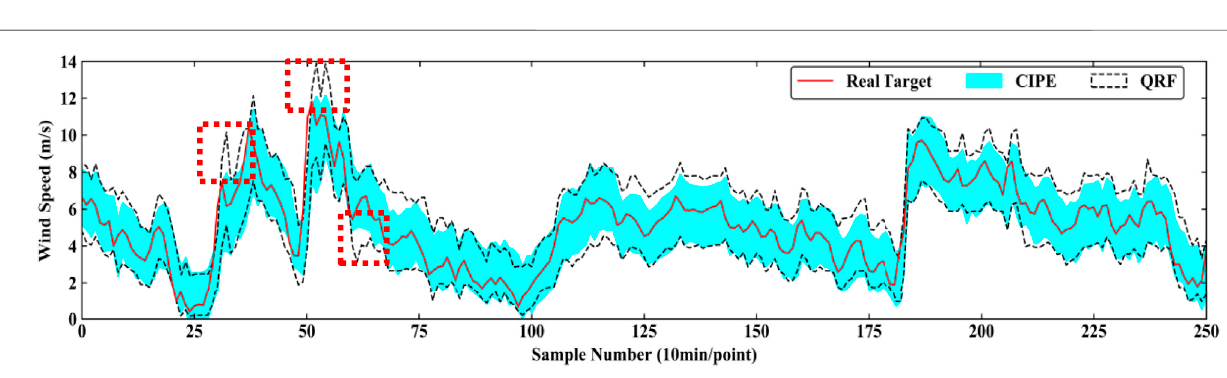
Frontiers in Energy Research |